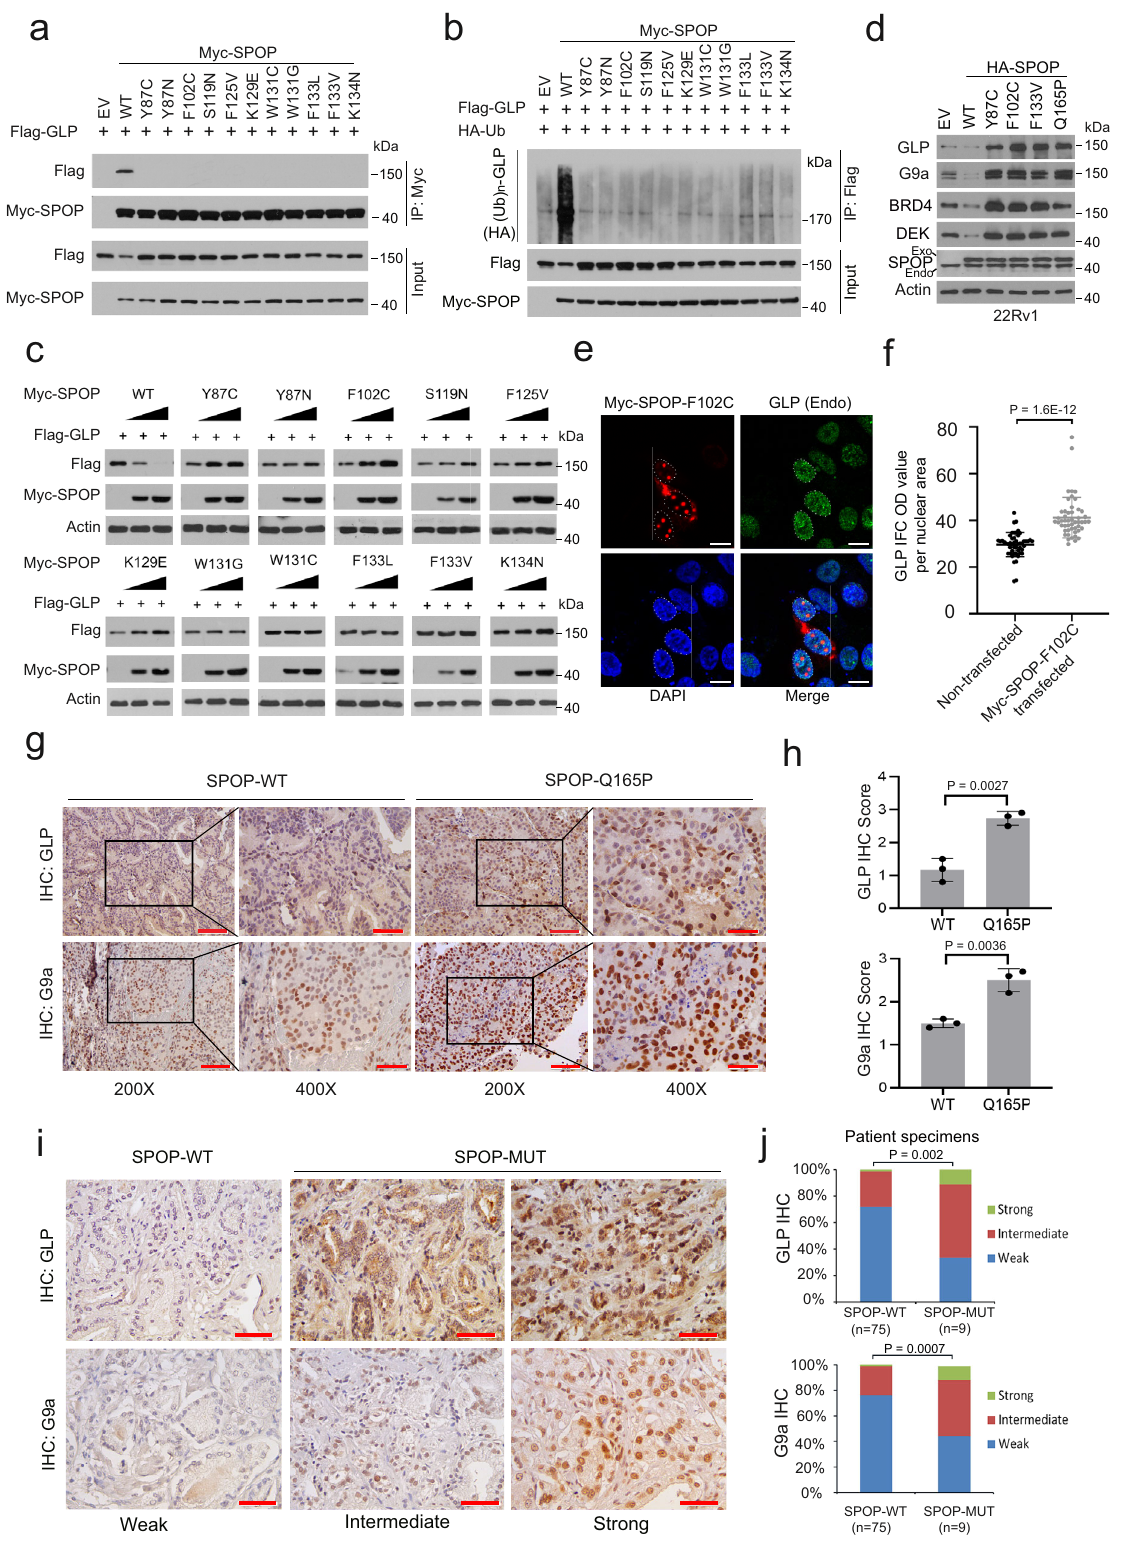
increased methylation of these genes in SPOP-mutant cells is reversed by GLP knockdown (Fig. 5g, h). In contrast, knockdown of several other SPOP degradation substrates including AR, BRD4, and PD-L1 did not reverse SPOP F133V-induced hypermethylation of these genes (Supplementary Fig. 6a, b). Furthermore, re-introduction of WT SPOP or treatment of the